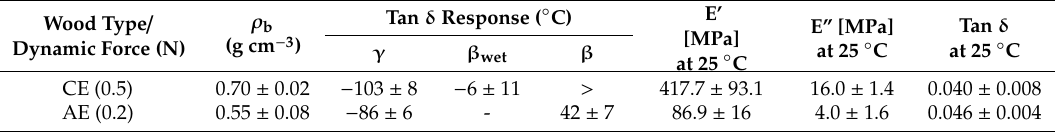
Table 2. Mean values ( ± standard deviations) of MC at the start of the measurement, bulk density of wood samples ( ρ b ), tan δ response in the whole range of temperatures and average values of E’, E” and tan δ at 25 ◦ C.